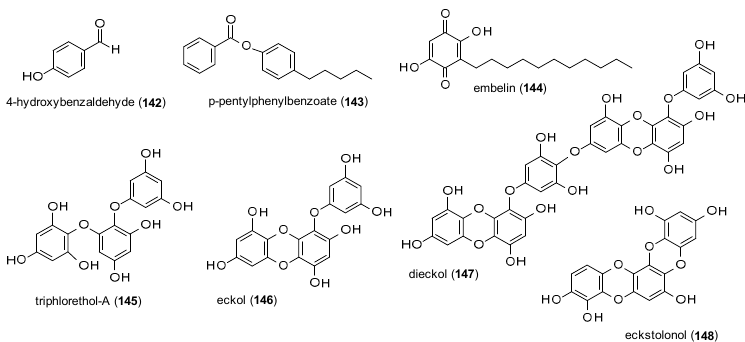
Figure 10. Chemical structures of simple phenols and polyphenols with reported GABA(A)-receptor modulating activity.